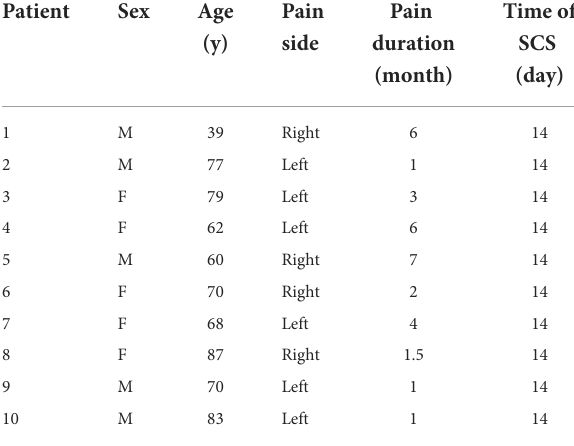
TABLE 1 Individual patient’s characteristics for all patients ( N =